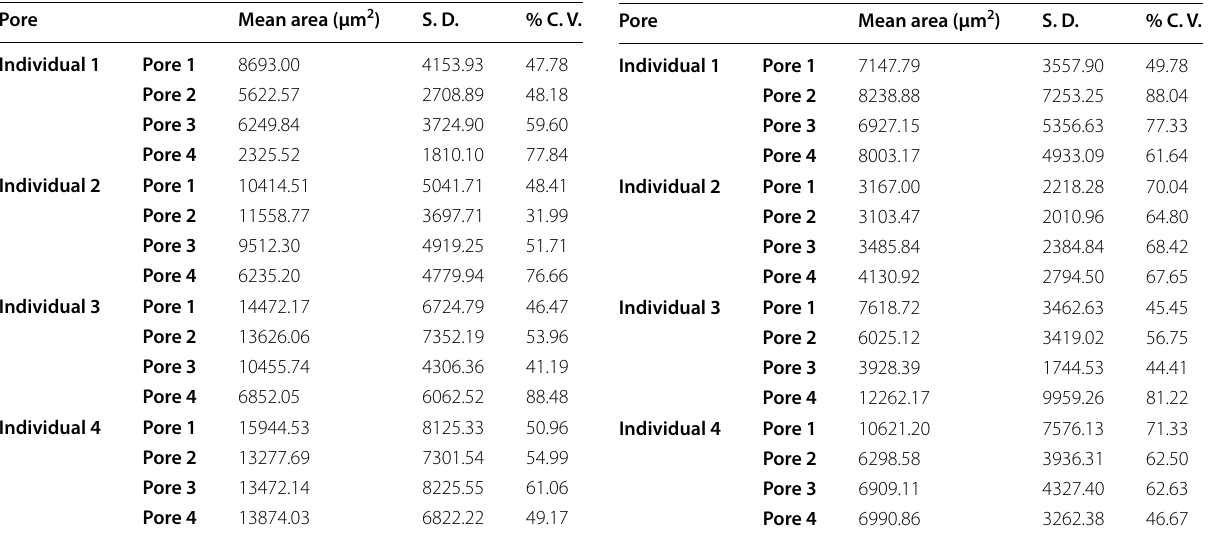
Table 3 Mean area, standard deviation (S. D.), and % coefficient of variation (% C.V.) of four pores, taken from fingerprints obtained from the right thumb of four individuals on sticky side of adhesive tape (using method (iii)), recorded on ten consecutive days, show % C. V. to be beyond the normal acceptable level (with 5% confidence level in analytical